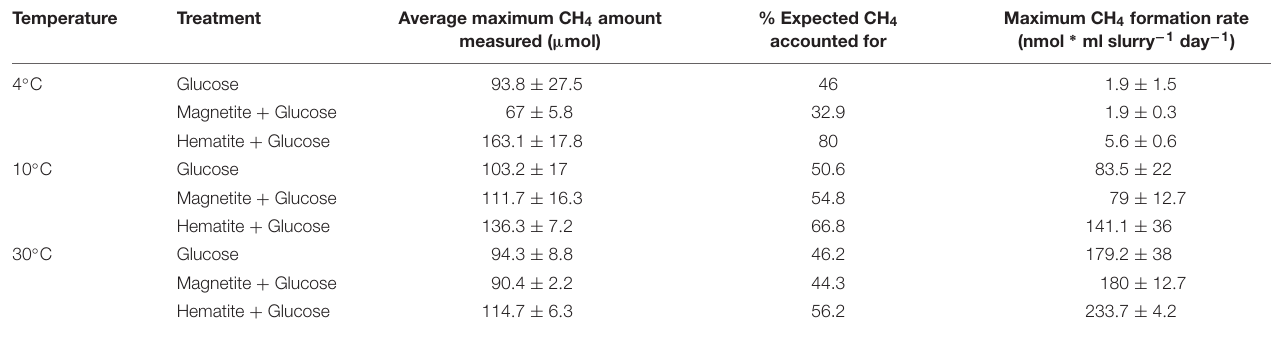
TABLE 1 | Average amounts of methane formed and maximum methanogenesis rates per treatment across temperatures.